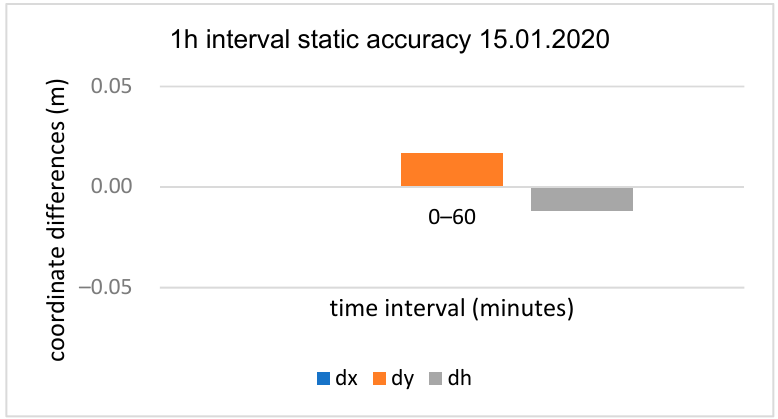
Figure 10. 60 min session positioning results for initial test, baseline OPNT–P30Pro (4 km).